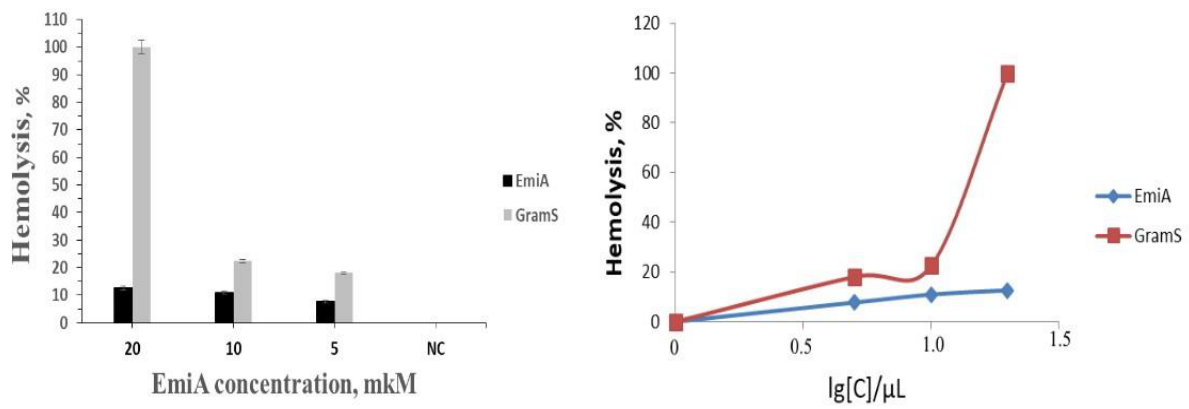
Figure 4. Hemolytic activity of EmiA and gramicidin S (GramS) on human erythrocytes. Designations: NC: Negative control (0.9% solution of NaCl); the assay was repeated in triplicate, and the percentage of hemolysis is expressed as the mean ± SD.